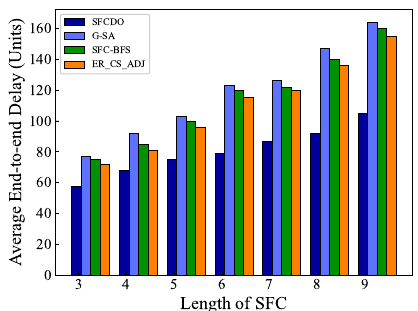
Figure 5. Average end-to-end delay of SFCs in small topology.